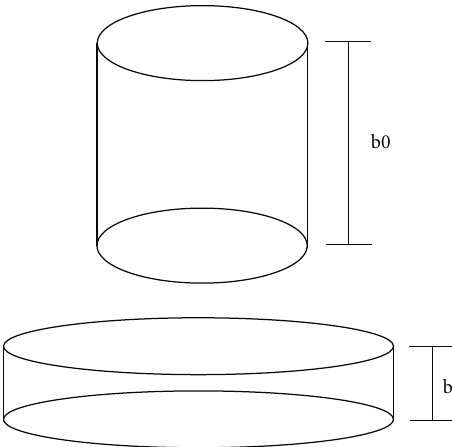
Figure 7: Schematic diagram of proppant stress